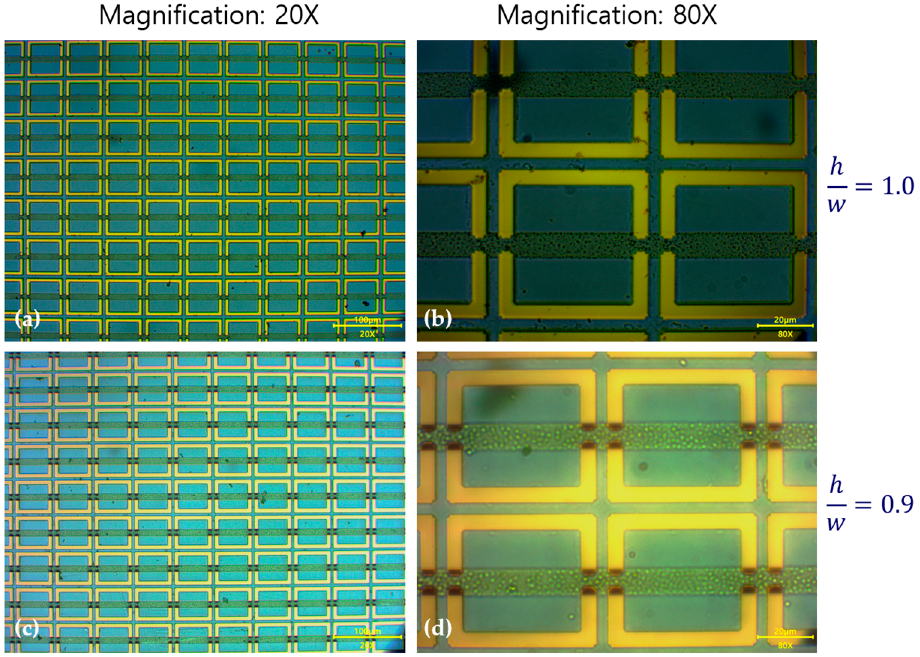
Figure 6. Photographs of the double-split rectangular metamaterial with various aspect ratios based on etched VO 2 thin films. ( a ) Magnification: 20×, h/w = 1.0, ( b ) magnification: 80×, h/w = 1.0, ( c ) on etched VO 2 thin films. ( a ) Magnification: 20 × , h/w = 1.0, ( b ) magnification: 80 × , h/w = 1.0, magnification: 20×, h/w = 0.9, ( d ) magnification: 80×, h/w = 0.9. ( c ) magnification: 20 × , h/w = 0.9, ( d ) magnification: 80 × , h/w =